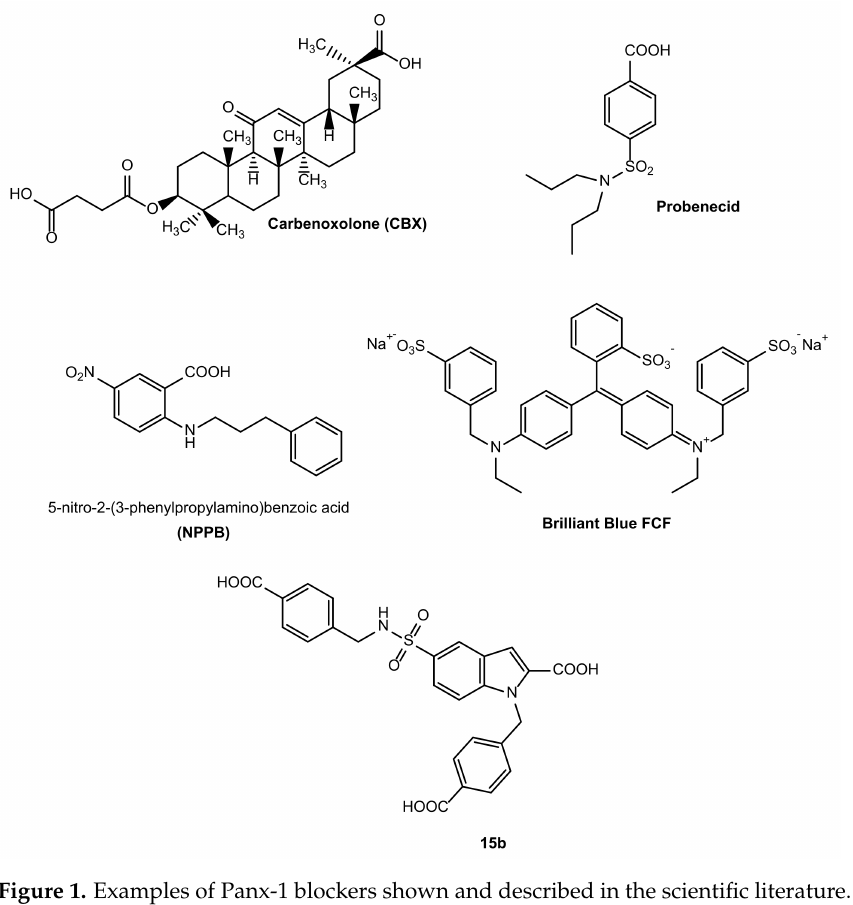
Figure 1. Examples of Panx-1 blockers shown and described in the scientific literature.